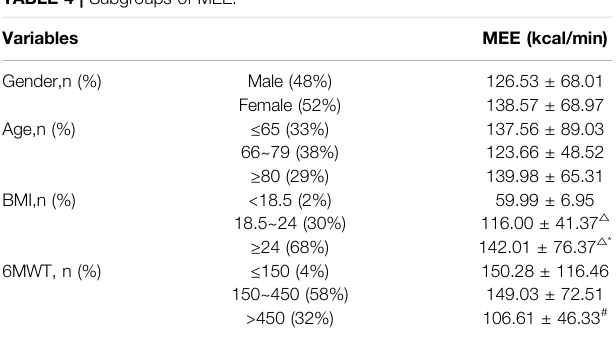
TABLE 4 | Subgroups of MEE.